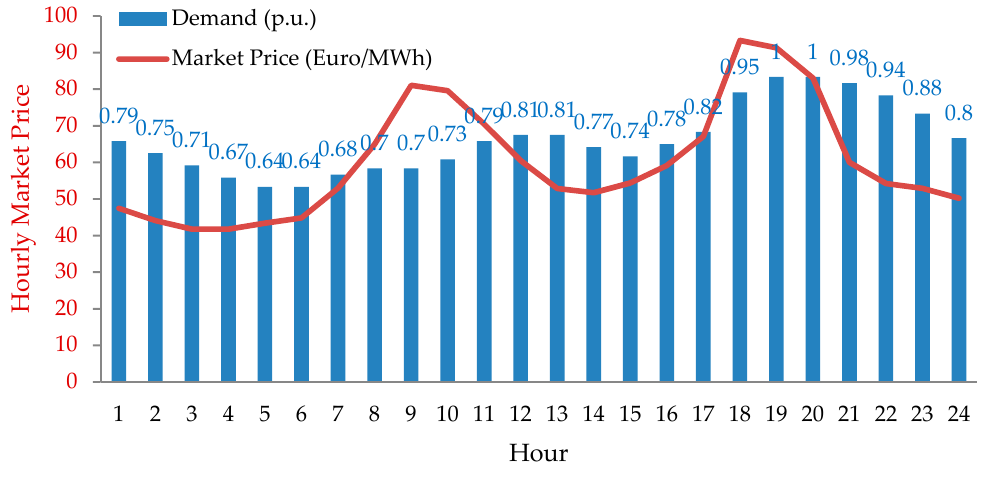
Figure 2. Daily load and price profiles of the 33-bus test RMG system and power price curve, comparatively.